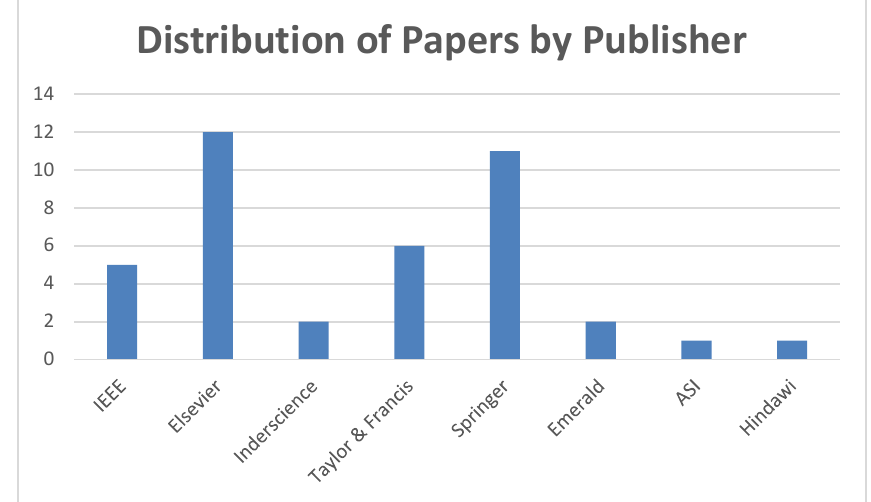
Fig. 3. Distribution of papers by publisher